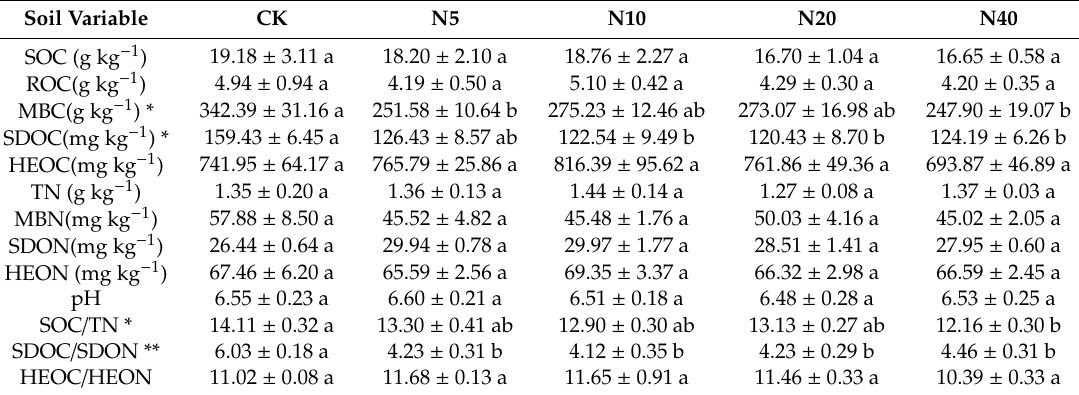
Table 5. Variations in soil variables at different nitrogen additions rates.